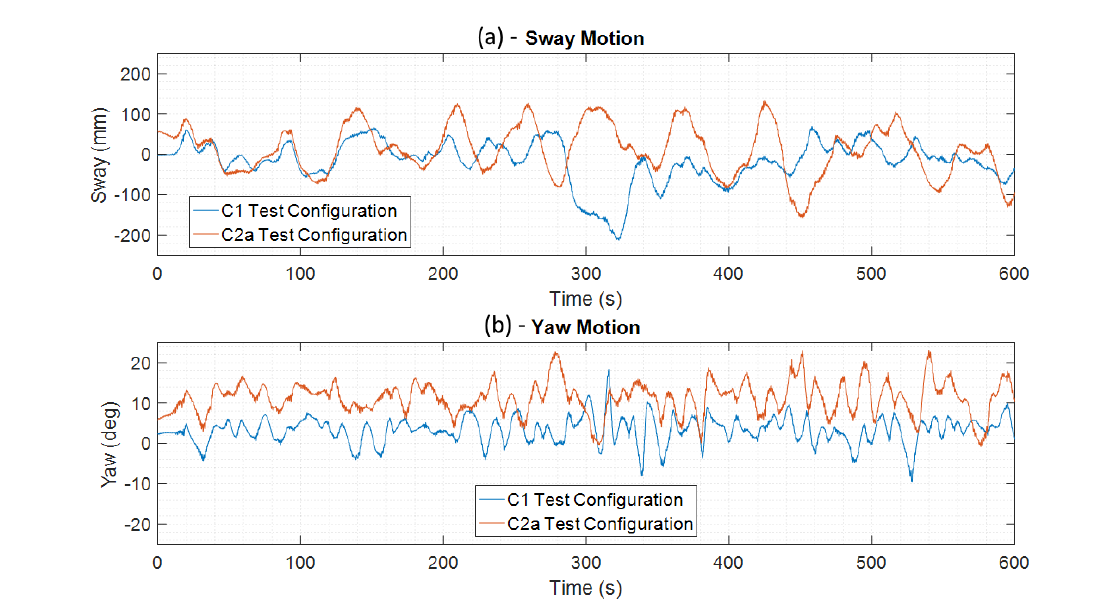
Figure 17. Sway ( a ) and yaw ( b ) time histories for the two mooring configuration tests in the irregular wave condition.